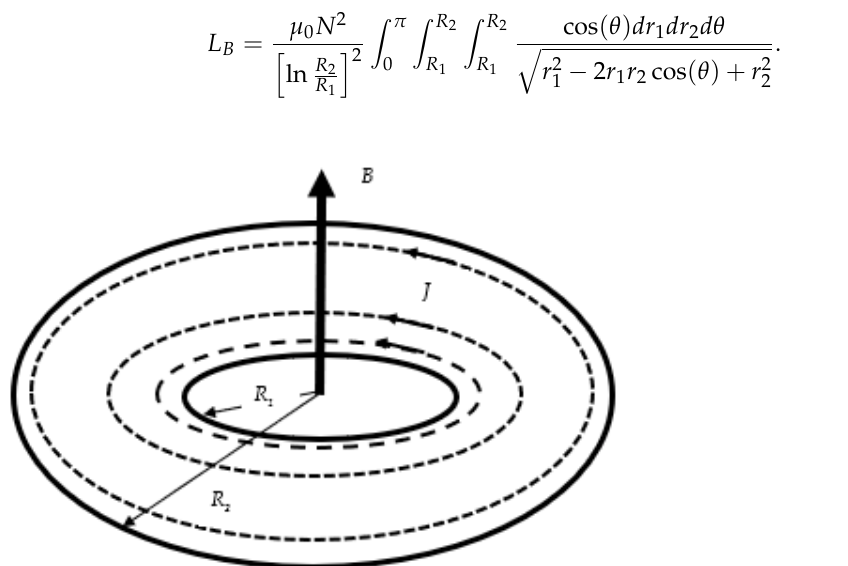
Figure 3. Thin disk Bitter coil carrying the azimuthal current density J and which has a variation according to the radius r , R 1 ≤ r ≤ R 2 which is